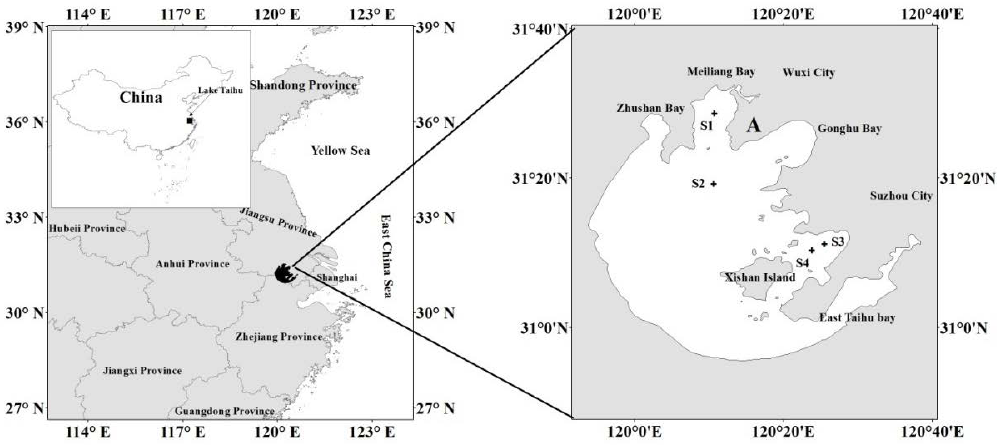
Figure 1. Sampling sites S1, S2, S3, and S4 in Taihu Lake. Table 1. Chemical characteristics of water samples (mg L − 1 ). Analytical results over one year for ammonia (N-NH 4 ), nitrate (N-NO 3 ), total nitrogen (TN), total dissolved nitrogen (TDN), chemical oxygen demand (COD), and chlorophyll a (Chl a) in water samples from the four sampling locations.